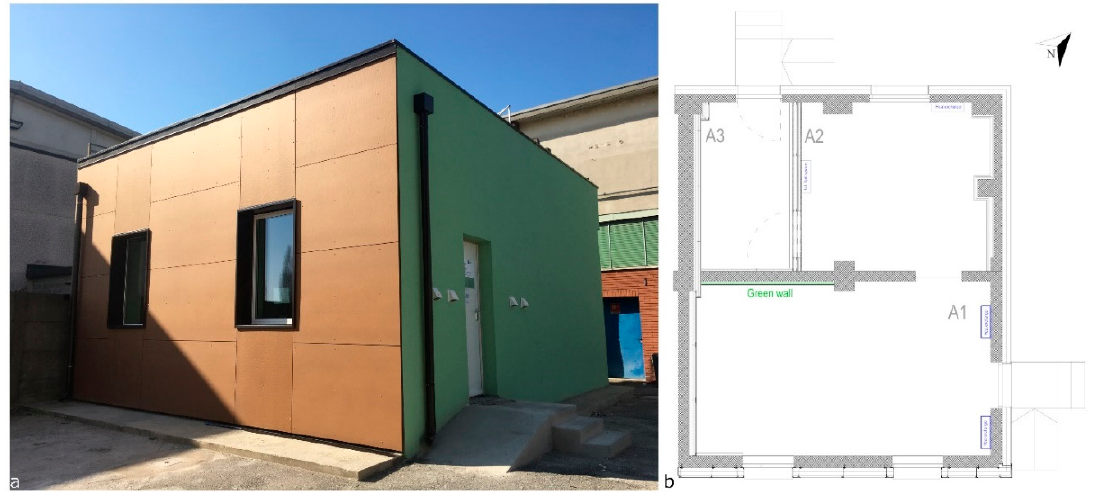
Figure 1. LabZEB: ( a ) outdoor view; ( b ) indoor plan.